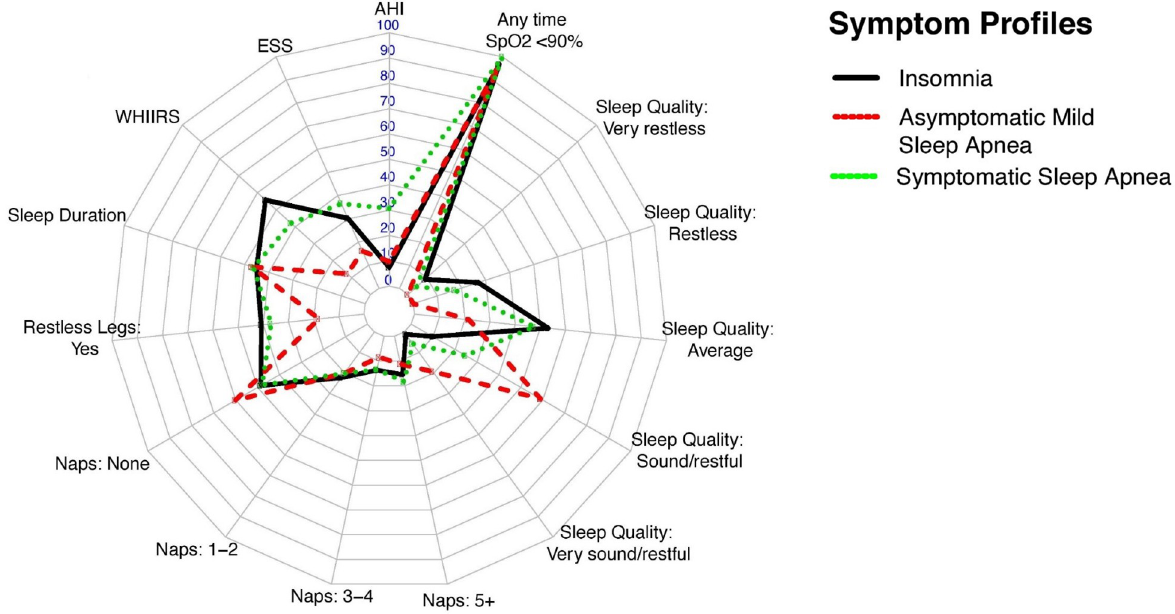
Fig 1. Symptom profile of primary latent class solution with HCHS/SOL individuals ages 45+ and AHI � 5. All variables were rescaled to be on a 0–100 scale. Continuous indicators were rescaled using min-max normalization ([x-min(x)]/[max(x)-min(x)]) � 100. Categorical indicators are presented using the prevalence in %